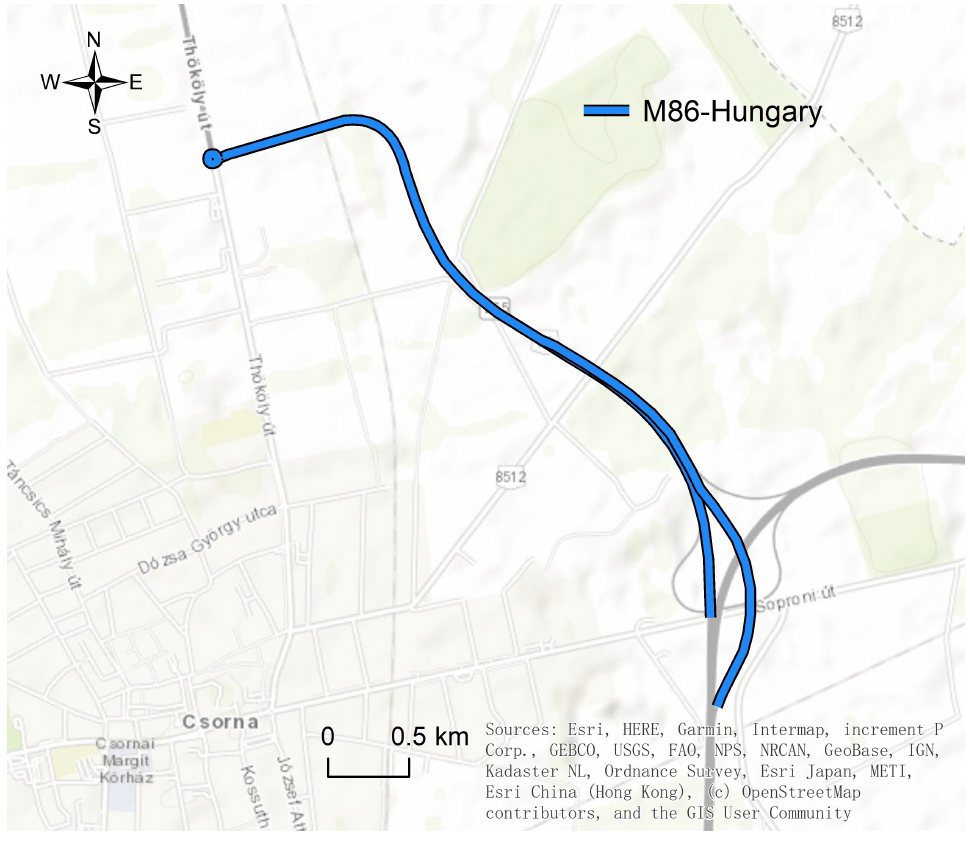
Figure 3. M86 freeway located near Csorna (Hungary) on route E65 (GNSS coordinates: 47.625778,